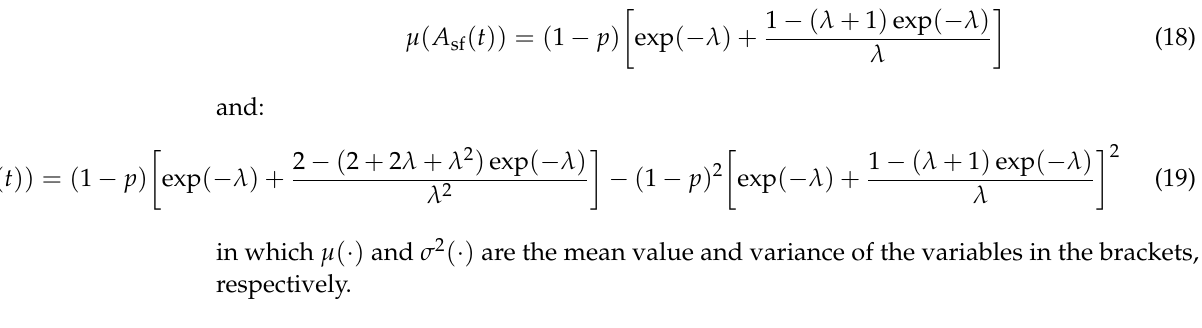
Table 1. Probability distribution of A sf ( t )